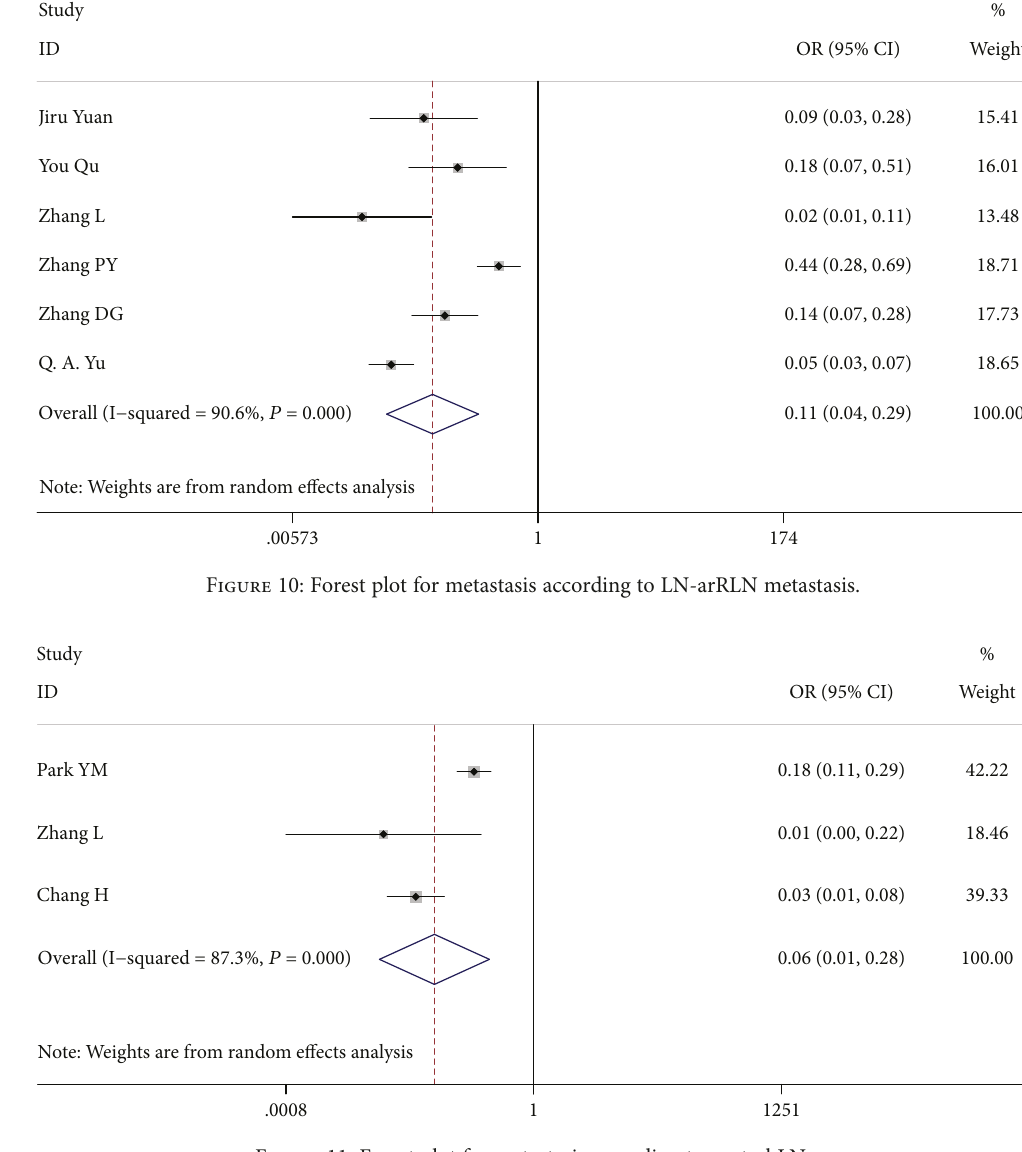
Figure 11: Forest plot for metastasis according to central